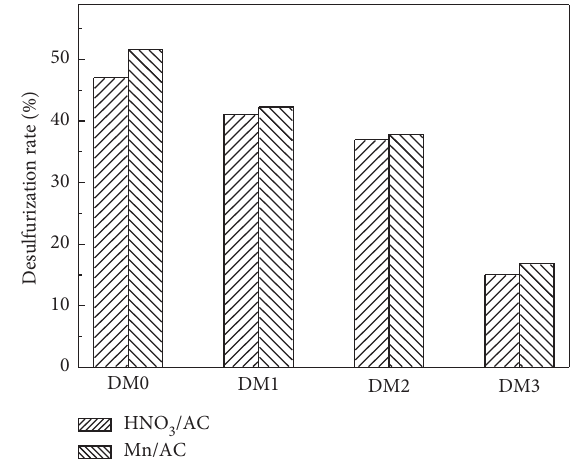
Figure 9: Effect of competitive adsorption ( v 9.38mmol · L − 1 ; adsorbents, 0.1g; adsorption temperature, 313K; adsorption time: 4h; model oil: DM0, DM1, DM2, and